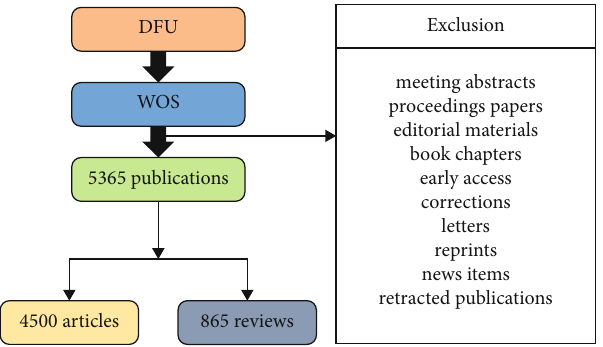
Figure 1: Retrieval strategy and number of